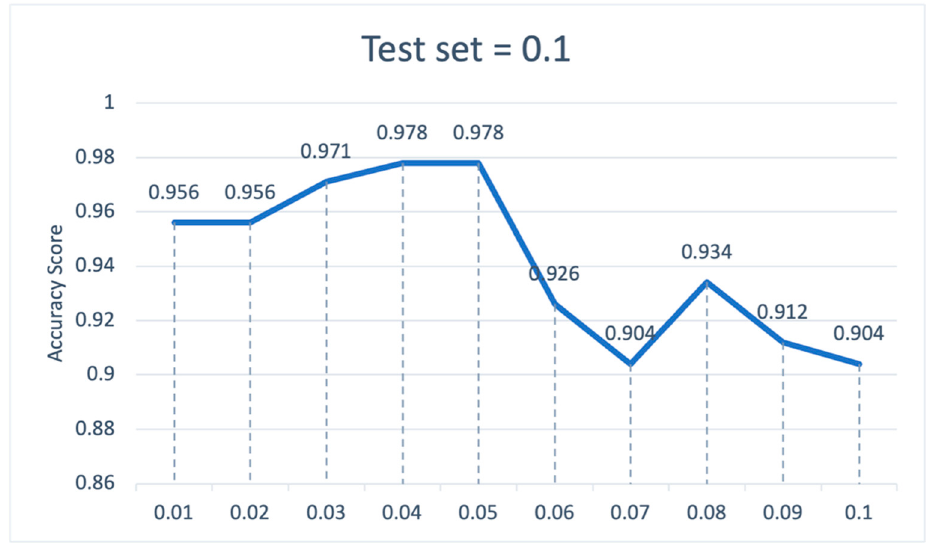
Figure 9. The model accuracy in different threshold levels. (Test set = 0.1).